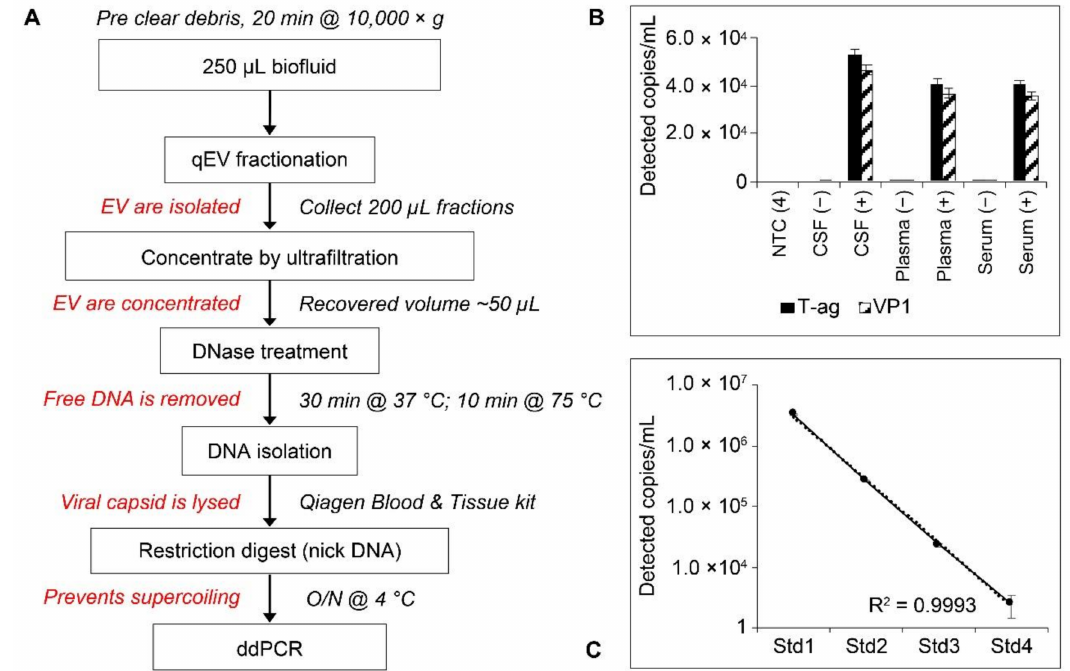
Figure 6. ( A ) Workflow and absolute quantification of JCPyV in plasma-, serum-, and CSF-derived EV. Healthy donor control samples were either spiked with infectious EV or PBS control. EV were isolated and concentrated, and viral DNA was extracted. Following digestion, ddPCR was performed to determine viral genome number. ( B ) There was consensus both within and between biofluid types for detected viral copies. Standard curve of Mad1-pBR322 plasmid DNA by ddPCR. ( C ) Detected genome equivalent count matched the known input for each standard and was reproducible. R 2 = 0.9993. ddPCR = droplet digital PCR; NTC = no-template control; O/N = overnight; PBS = phosphate-buffered saline; T-ag = T-antigen. Error bars represent the standard